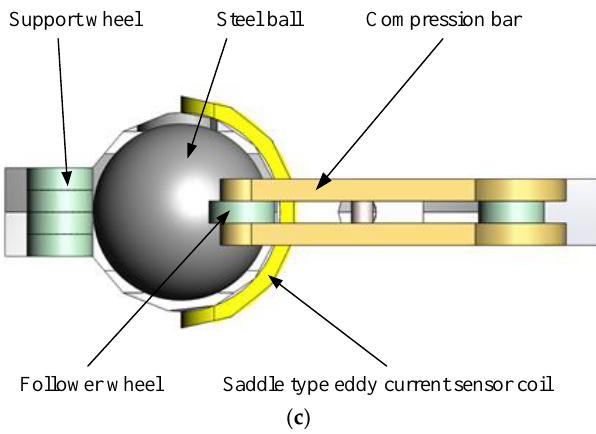
Figure 1. The unfolding mechanism of the steel balls. ( a ) The main view of the unfolding mechanism; ( b ) a cutaway view of the unfolding mechanism; and ( c ) the top view of unfolding mechanism.